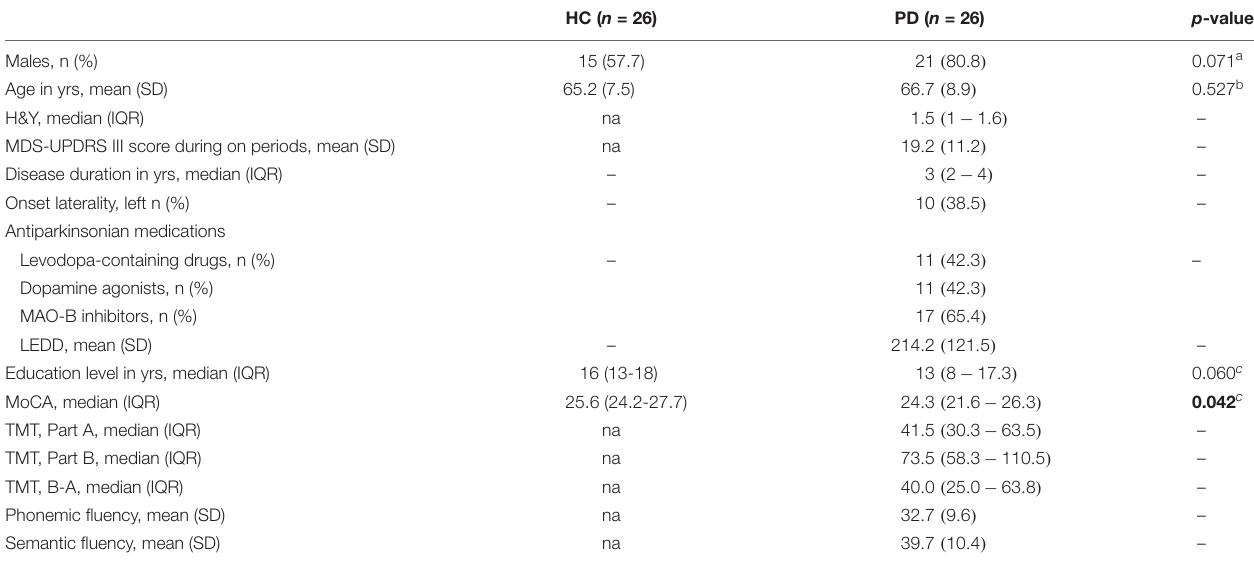
TABLE 1 | Demographic and clinical characteristics of the participants of the